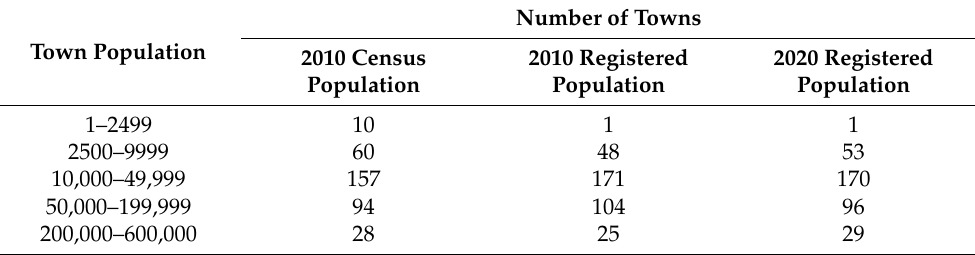
Table 1. Number of towns and varying population.